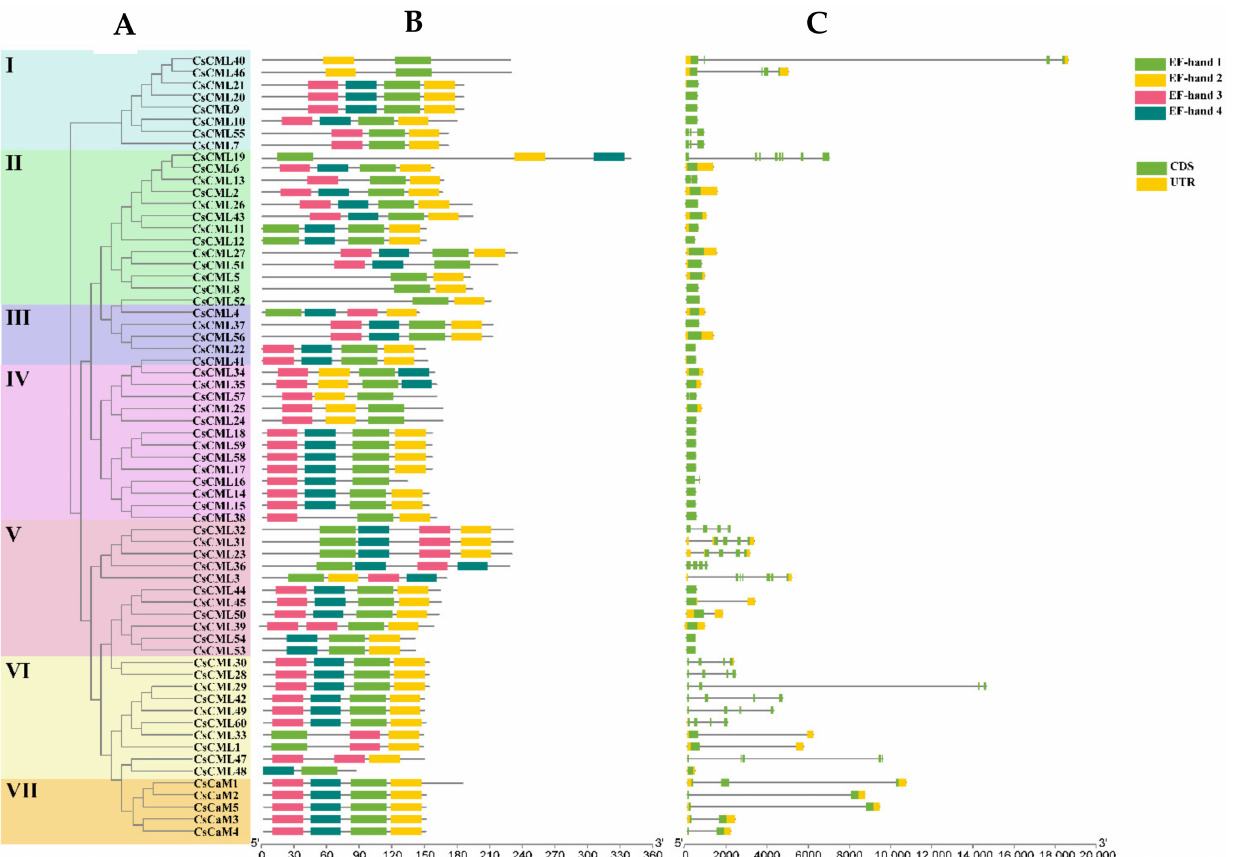
Figure 1. Phylogenetic relationships, motif compositions, and gene structure of Camellia sinensis CaMs and CMLs. ( A ) Phylogenetic tree and classification of CsCaM and CsCML proteins. The CsCaM and CsCML can be divided into seven clades which are denoted as subgroups 1–7 from top to bottom. ( B ) Schematic representation of the conserved EF-hand motifs among the CsCaM and CsCML proteins as obtained by MEME analysis. Each color represents a specific motif. ( C ) Exon/intron organization of tea CsCaM and CsCML genes. The exons, introns, and UTRs are represented by yellow boxes, fold lines, and green boxes,